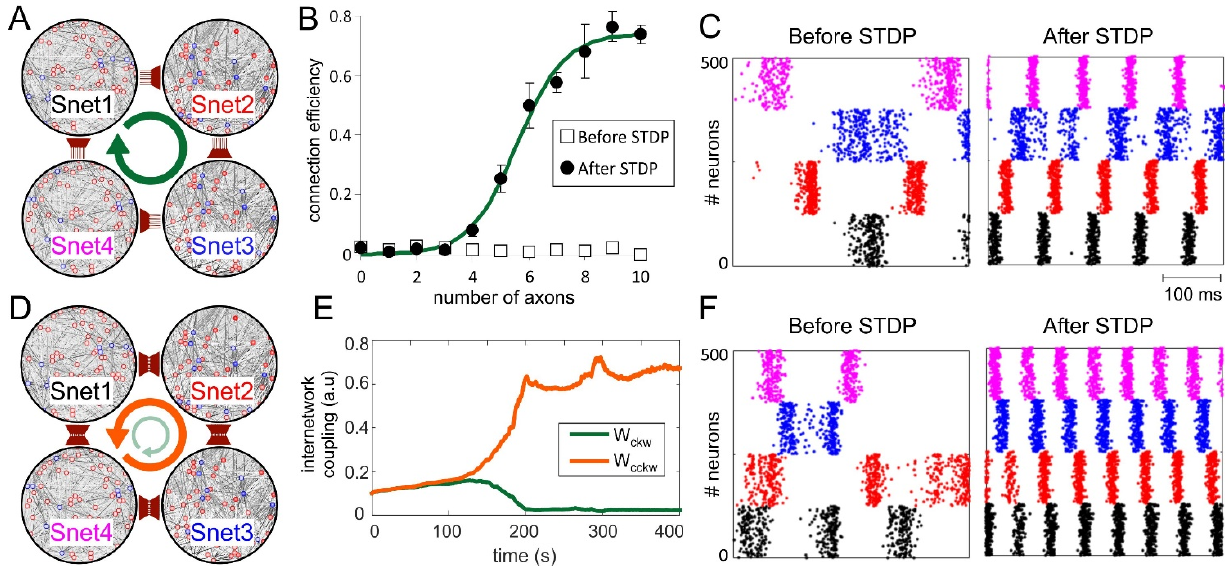
Figure 3. Emergence of cyclic structures and rhythmic activity. ( A ) Architecture with unidirectional clockwise connections facilitates a clockwise cyclic activity. ( B ) The connection efficiency (bursts passing from one subnet to another) vs. the number of connections between subnets ( A ) before and after learning. ( C ) Raster plots of spiking activity before and after learning. Learning leads to the emergence of a wave circulating in the network. Colors indicate spikes of neurons from the corresponding subnets shown in ( A ). ( D ) Initial architecture with bidirectional connections. A cyclic activity running either clockwise or counterclockwise can emerge. ( E ) An example of the weight’s dynamics: W ckw and W cckw are the average weights of clockwise and counterclockwise connections, respectively. Clockwise connections are depressed, while counterclockwise couplings are potentiated. ( F ) Example of raster plots for the bidirectional SNN with a counterclockwise activity after